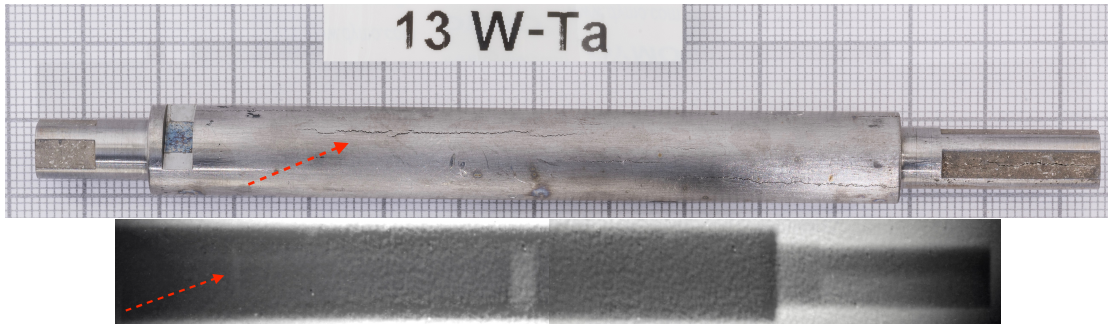
Figure 12. Radiograph of the HiRadMat-27 Ta-cladded W rod (bottom panel). The red arrows highlight two big cracks forming a cross-like structure, of which the vertical one is not visible from the outside. In this case, the radiograph highlighted in fact a crack in the inner W-core.